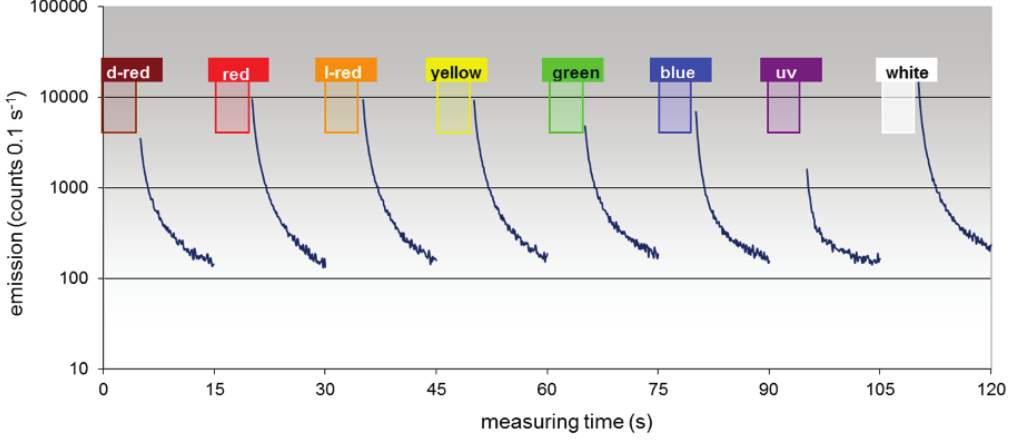
Figure 2: Decaying curves of delayed luminescence during one measuring cycle of a carrot sample, consisting of consecutive intervals of excitation with different wavelengths and subsequent detection of emission (based on Strube and Stolz